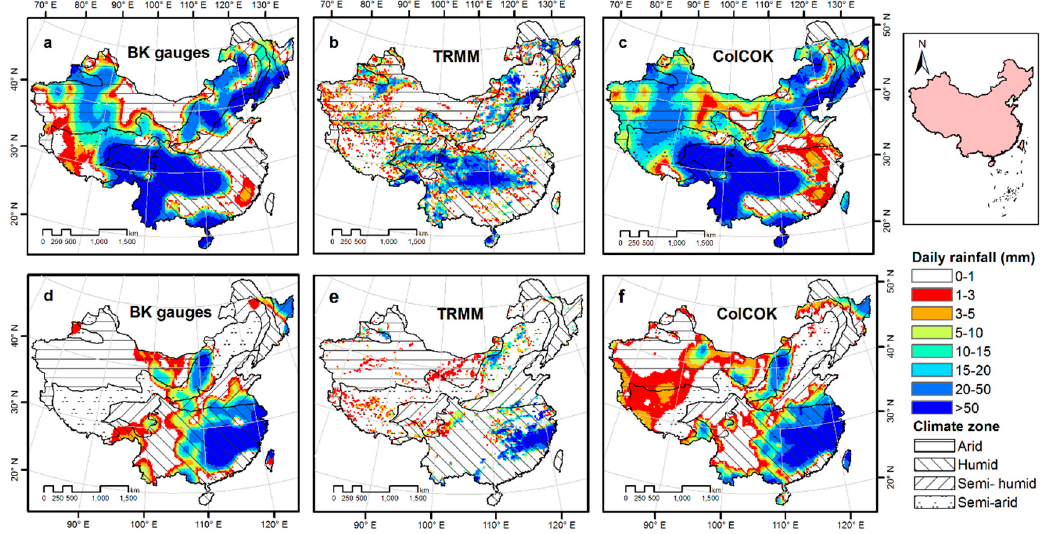
Figure 2. Semi-variogram of block-kriging (BK) gauges rainfall data for ( a ) 3 June 2012 and ( b ) 9 November 2012; cross-correlogram between the BK gauges and TRMM data for ( c ) 3 June 2012 and ( d ) 9 November 2012.